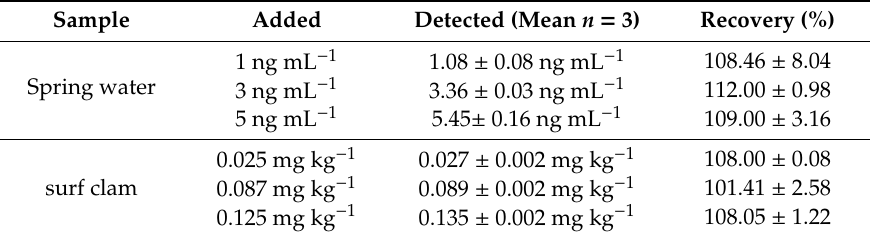
Table 1. Recovery ratio of Cd 2 + in spring water and surf clam samples.